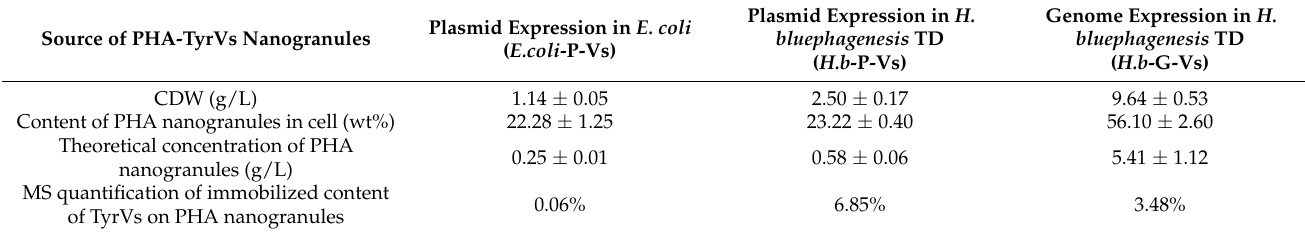
Table 1. Characteristics of PHA-TyrVs nanoparticles produced in three